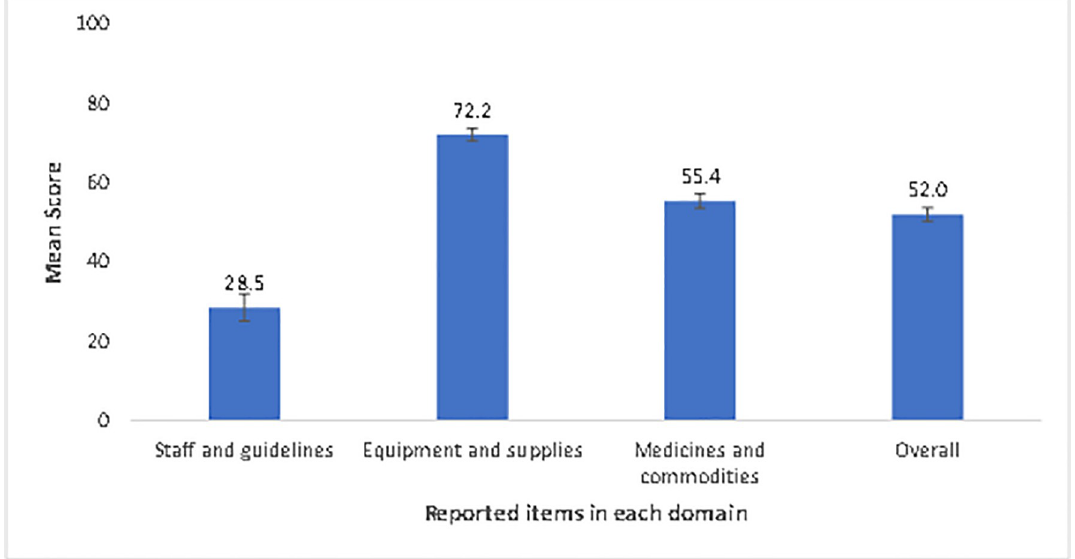
Fig 2. Mean score of the three domains of readiness to provide